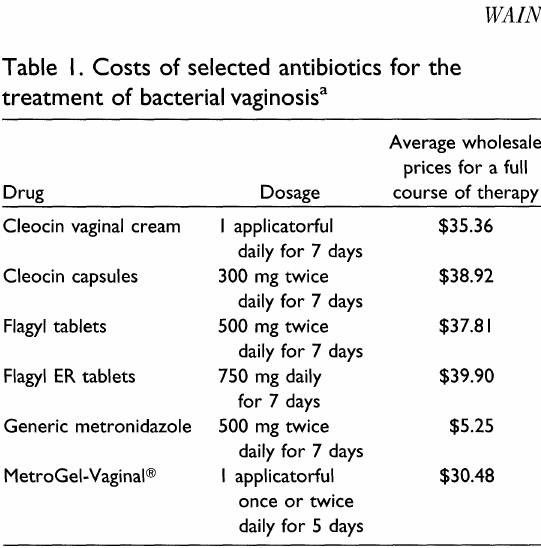
Table I. Costs of selected antibiotics for the treatment of bacterial